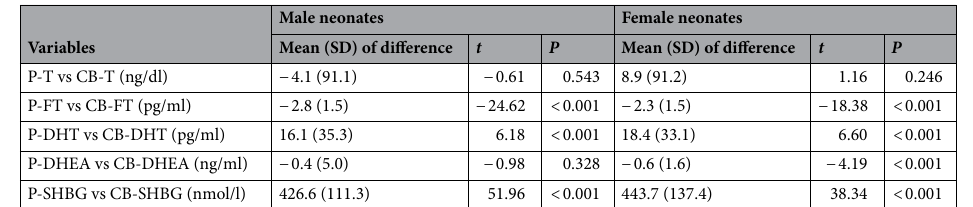
Table 2. Comparisons of differences between prenatal androgens and cord blood androgens. P-T prenatal testosterone, P-FT prenatal free testosterone, P-DHT prenatal dihydrotestosterone, P-DHEA prenatal dehydroepiandrosterone, P-SHBG prenatal sex hormone binding globulin, CB-T cord blood testosterone, CB-FT cord blood free testosterone, CB-DHT cord blood dihydrotestosterone, CB-DHEA cord blood dehydroepiandrosterone, CB-SHBG cord blood sex hormone binding